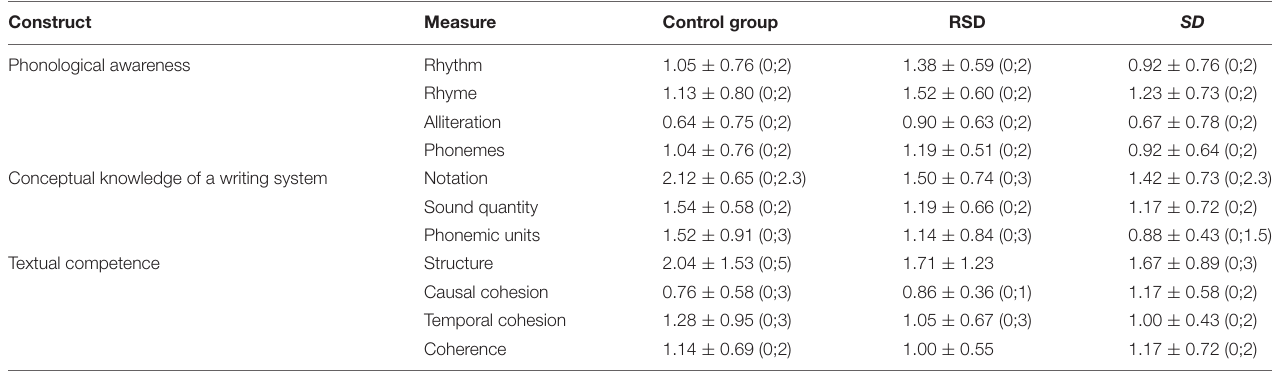
TABLE 2 | Descriptive statistics of kindergarten measures: mean and standard deviation (minimum; maximum).